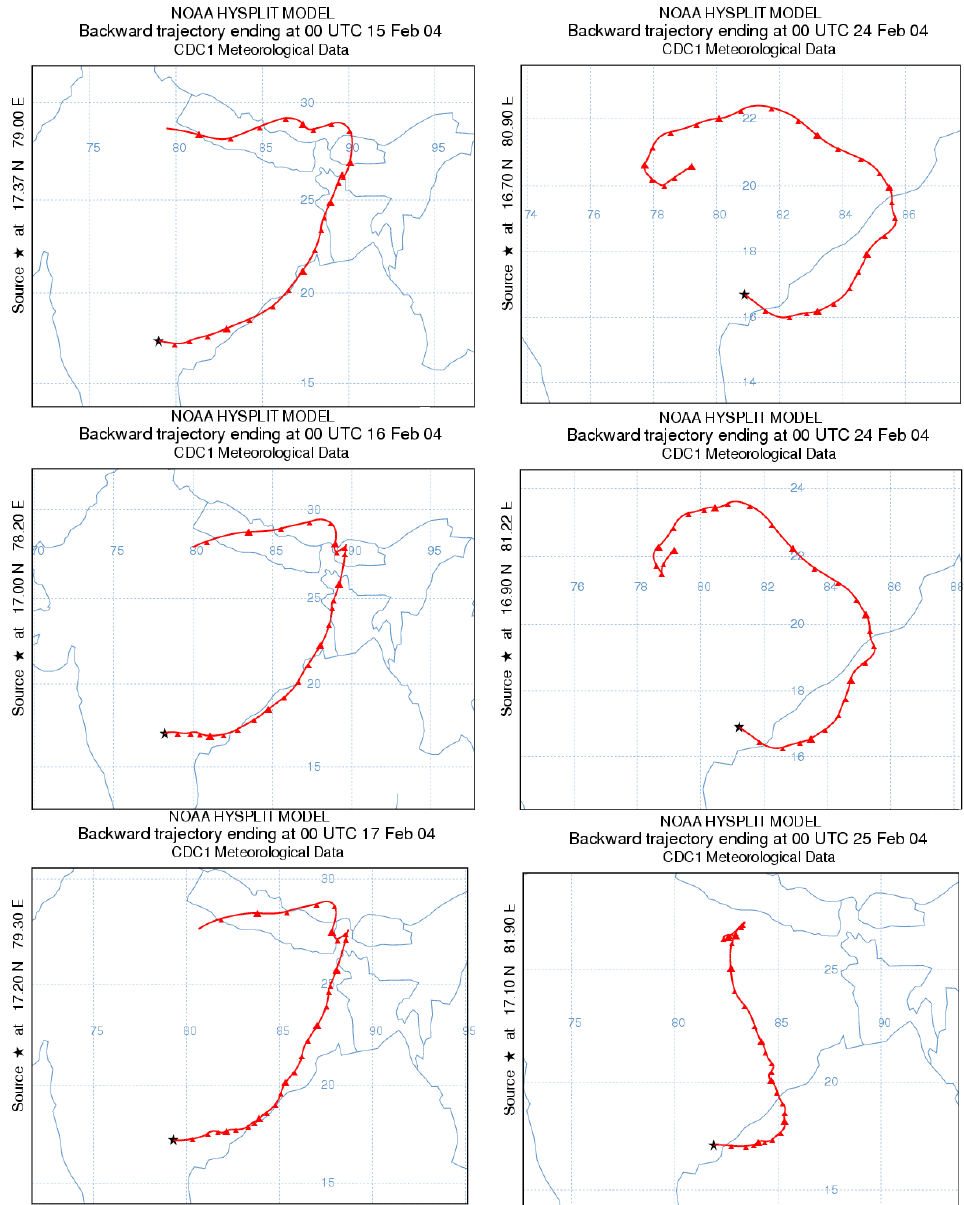
Fig. 10. Back trajectories for six typical cases with source locations at the southern observations sites for the respective day of observation produced with HYSPLIT from NOAA ARL web